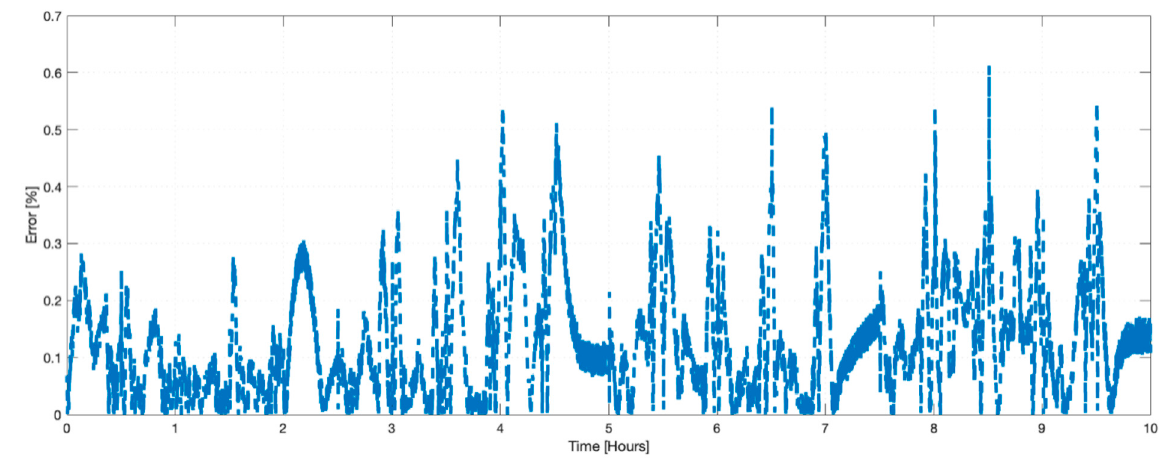
Figure 8. Cell I: Error rate versus time.